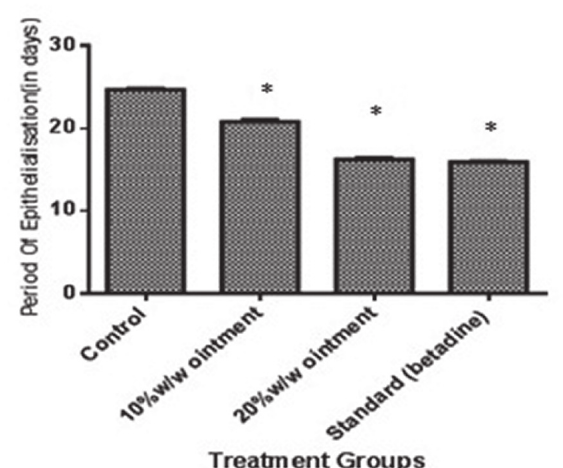
FIGURE 2 - Epithelialization Periods in different treatment groups in excision wound models.